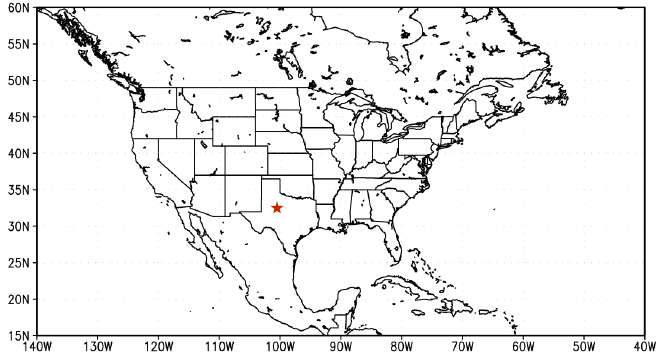
Figure 1. The location of Callahan Divide Wind Energy Center (denoted as a star) in relative to the US map.